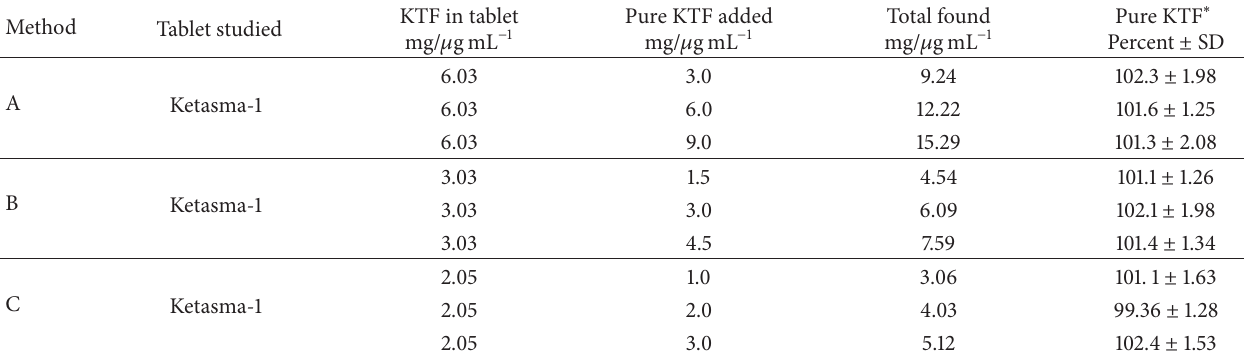
Table 6: Results of recovery study via standard addition method with